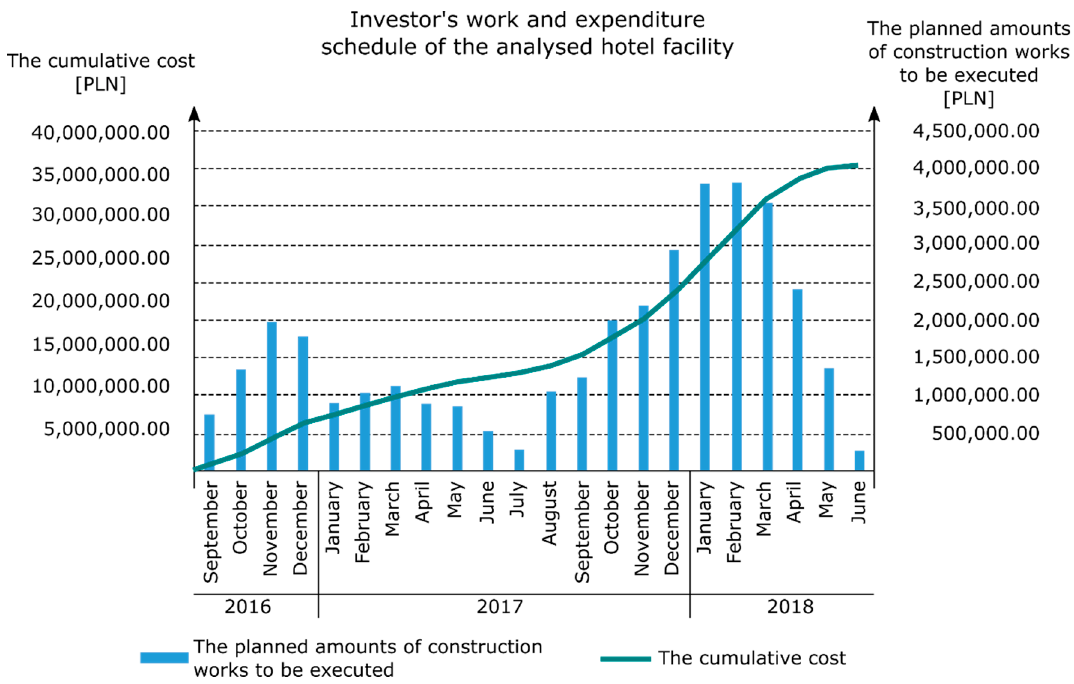
Figure 1. Investor’s work and expenditure schedule of the analyzed hotel facility (own